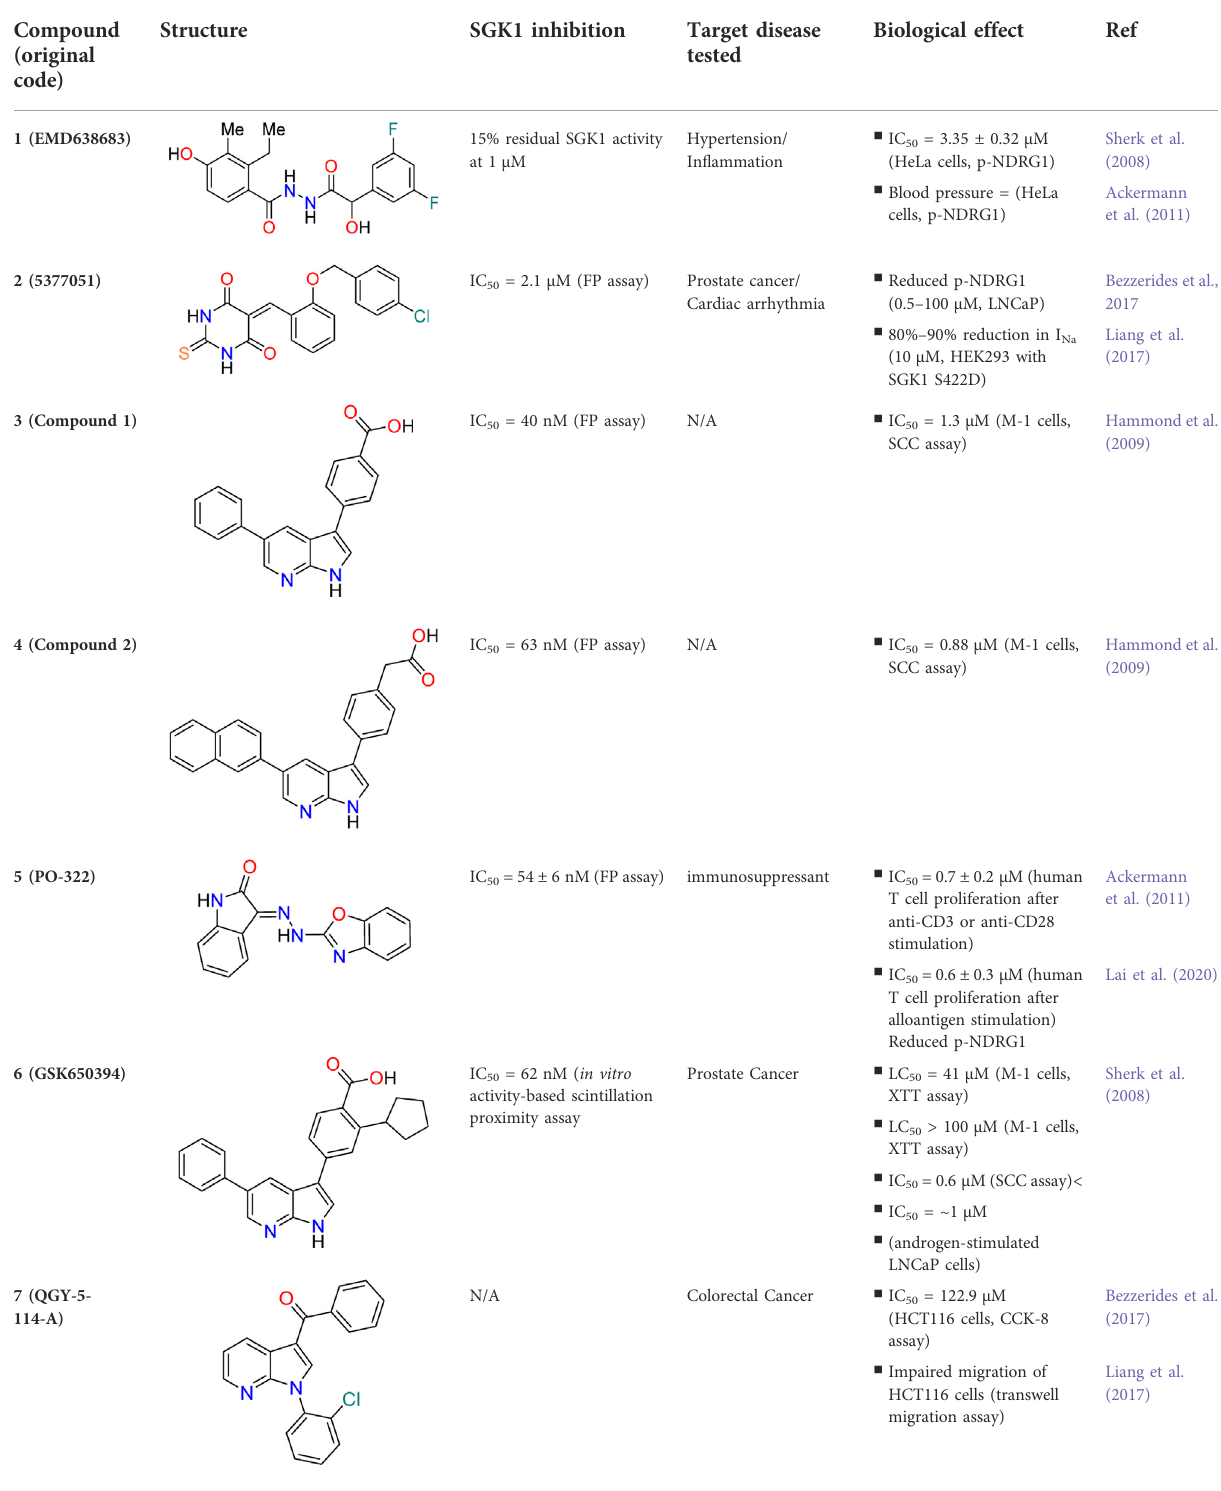
TABLE 1 Small-molecule serum and glucocorticoid-regulated kinase 1 (SGK1)